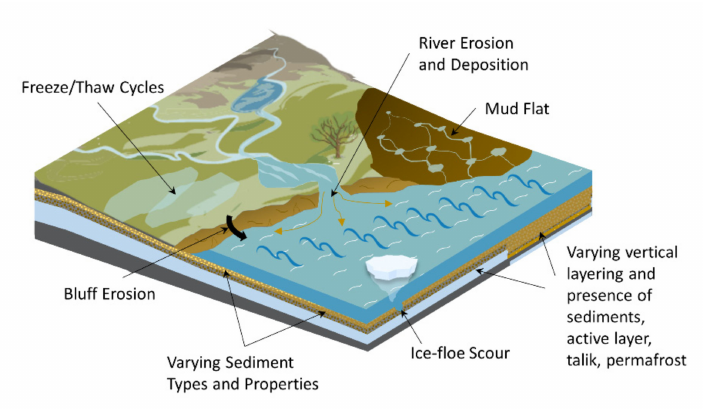
Figure 1. Simplified conceptual sketch of some processes affecting geotechnical Arctic coastal and nearshore sediment